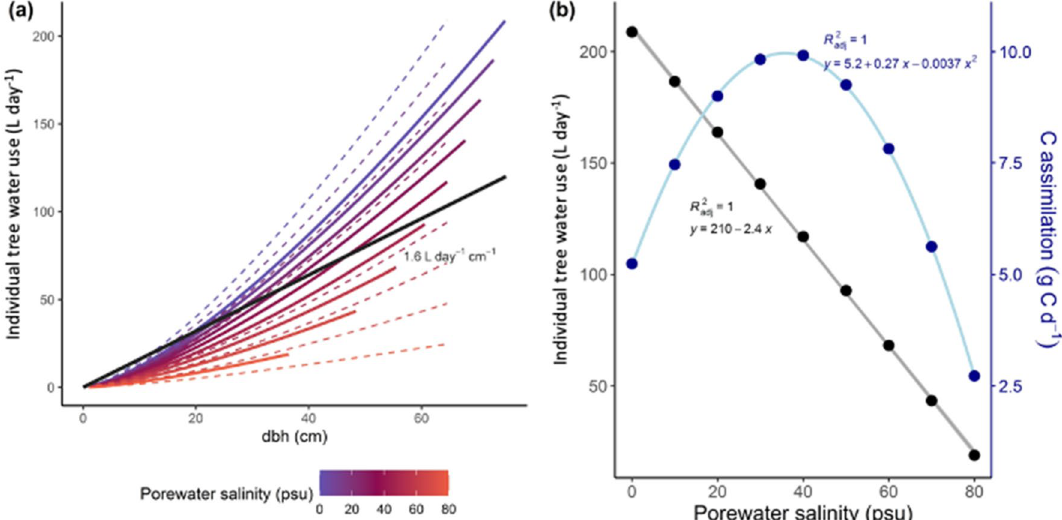
Figure 3. BETTINA model simulations applied to tree size and salinity vs. water use. ( a ) Individual tree water use from BETTINA modelling studies relative to dbh for different salinities within mangroves. Each solid line represents one tree over the time of simulation with trees adapting their allometry to variation in soil salinity (from blue for 0 psu to red for 80 psu). For comparison, dashed lines mark the water uptake at different salinities with no allometric adaptation (average tree allometry as growing at 40 psu); solid black line represents empirical individual tree water use estimated for mangroves in this study. ( b ) Simulated individual tree water use of each mangrove tree at an age of 200